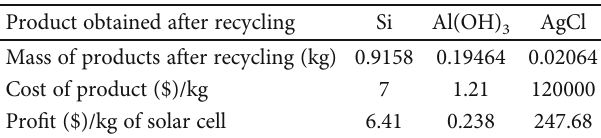
Figure 5: Top part of solar cell after removing antire fl ecting coating (pure silicon). Table 3: Amount of products recovered, cost of products, and pro fi t of